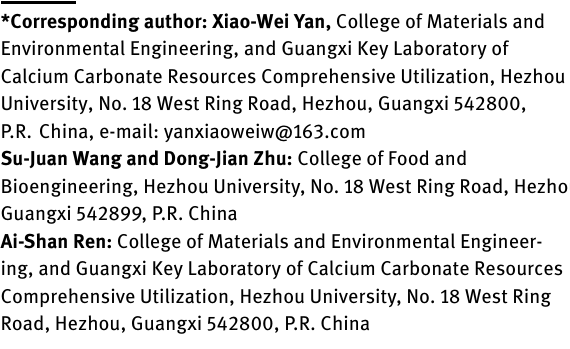
Table 1 contains crystallographic data and Table 2 contains the list of the atoms including atomic coordinates and dis- placement parameters.